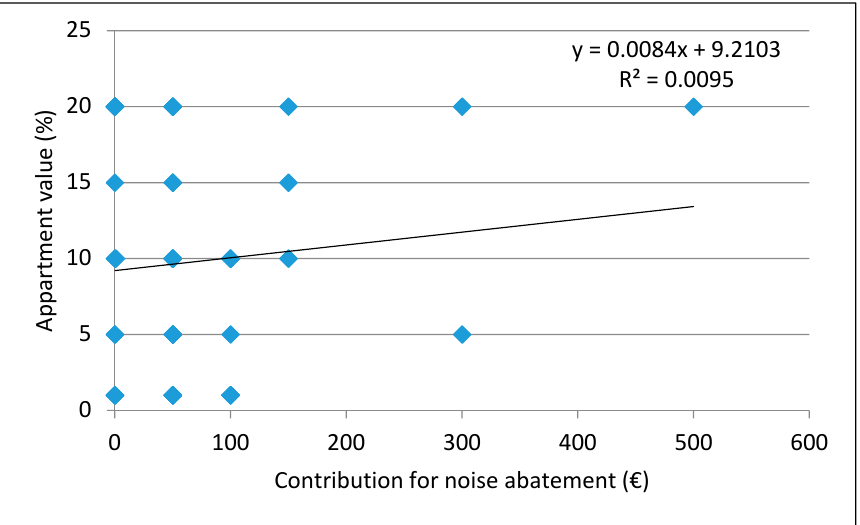
Figure 5. Dependence of attitudes about the noise influence on own apartment value on the amount of request for salary supplement due to noise.